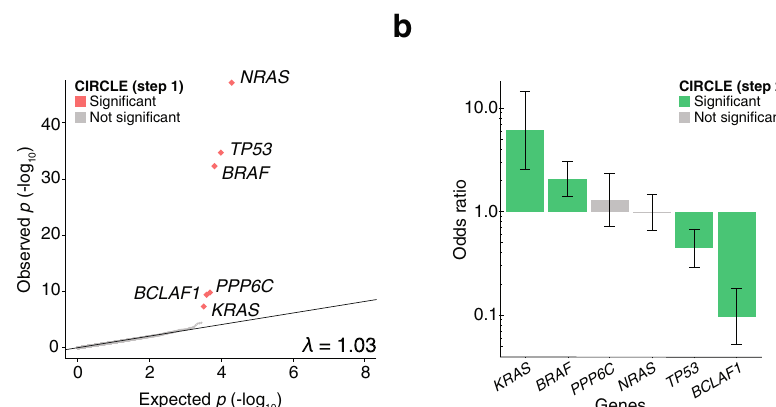
Fig. 2 A two-stage approach identi fi es BCLAF1 somatic genotype as a predictor of ICB response. a Quantile-quantile plot of fi shHook p -values to assess signi fi cance of gene mutational burden after removing confounders. The p -values were obtained by comparing observed mutational rate to the right tail (one-sided) of the expected mutational rates derived from a gamma-Poisson model of genome-wide mutational density and the covariates replication timing, epigenetic state, and sequence context. In the fi rst stage of CIRCLE, six signi fi cant genes were identi fi ed below a false-discovery threshold (FDR < 0.1). b Odds ratios (ORs) of response to ICB therapy in patients with a high or moderate impact mutation in the indicated gene as compared to patients that do not have a high or moderate mutation in the given gene ( n = 272 patients). Error bars indicate the 95% con fi dence interval of the odds ratio. ORs greater than one indicate enrichment in responders and ORs less than one indicate enrichment in non-responders. Statistical signi fi cance was tested using a two-sided Wald ’ s test of coef fi cients with multiple-hypothesis correction (FDR <